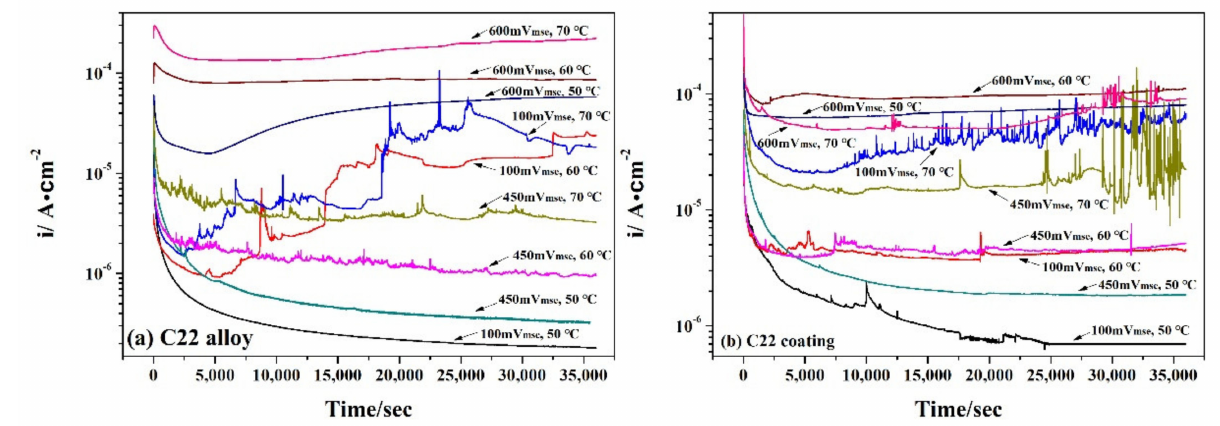
Figure 4. Current density vs. time plots recorded on C22 alloy ( a ) and C22 coating ( b ) during potentiostatic polarization.